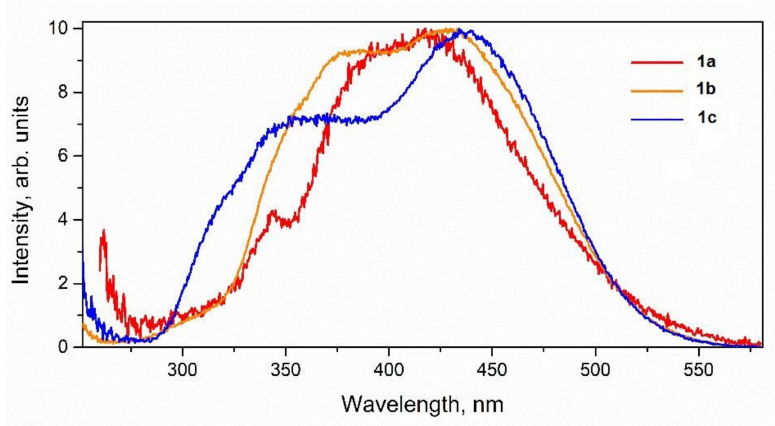
Figure 4. PL excitation spectra recorded with registration at the maxima of emission